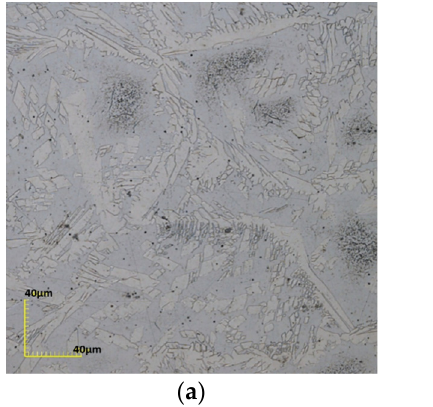
Figure 6. Microstructure observed in the FZ of the as-welded condition sample: ( a ) edge; ( b ) 1/4 region; ( c ) 1/2 region.